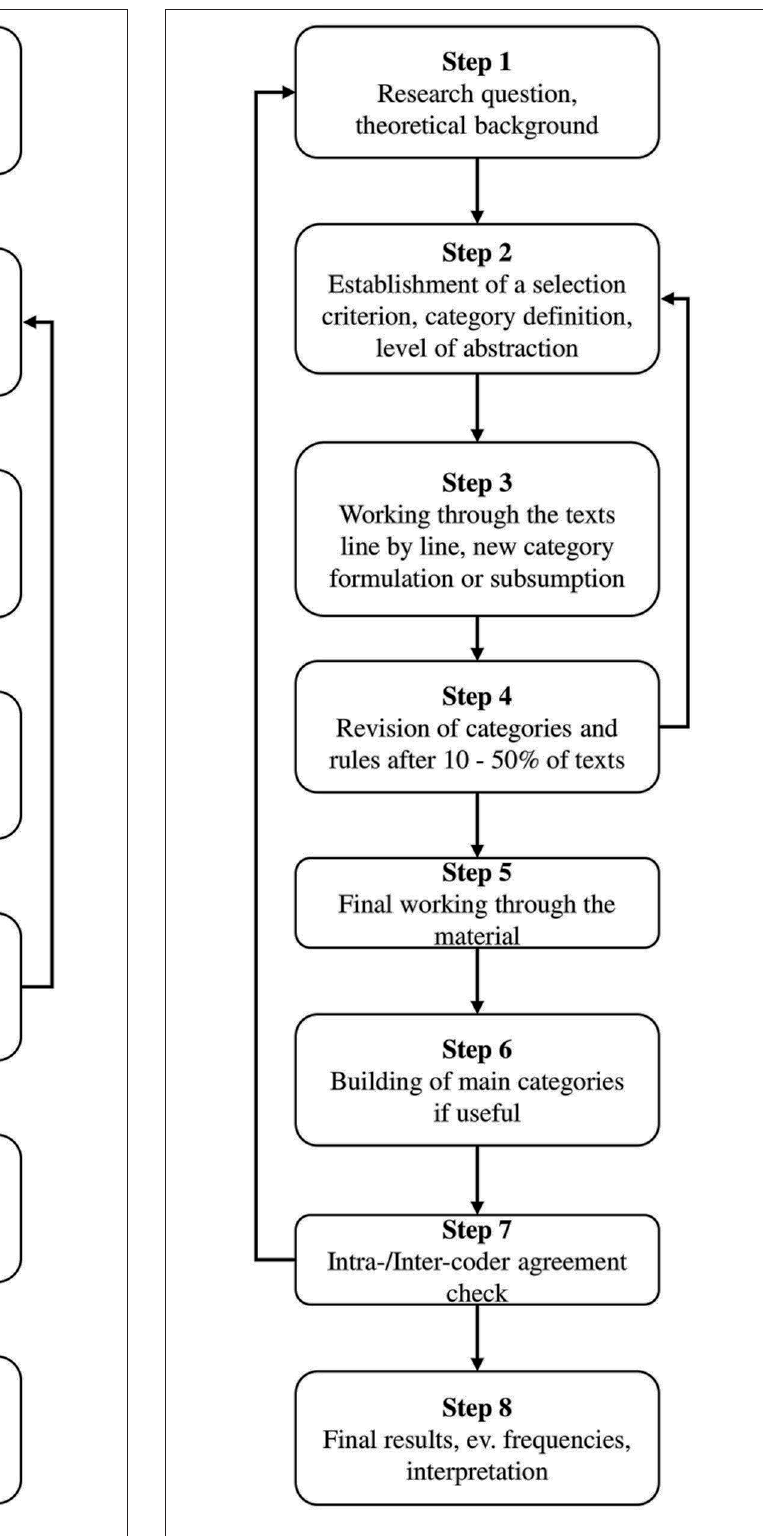
FIGURE 3 | Steps taken in the deductive approach. FIGURE 4 | Steps taken in the inductive